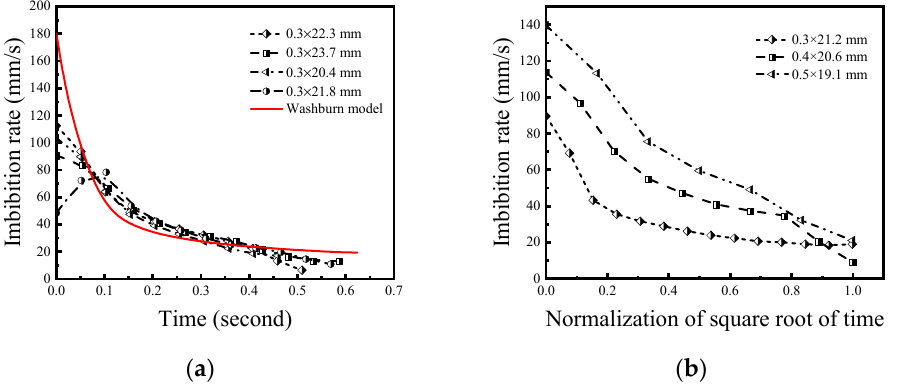
Figure 4. Diagram of the imbibition rate as a function of time. (( a ) shows the experimental results of water-displacing-air, ( b ) shows the experimental results of oil-displacing-air; these curves and point sets represent Washburn model’s prediction curves and the experimental results respectively).